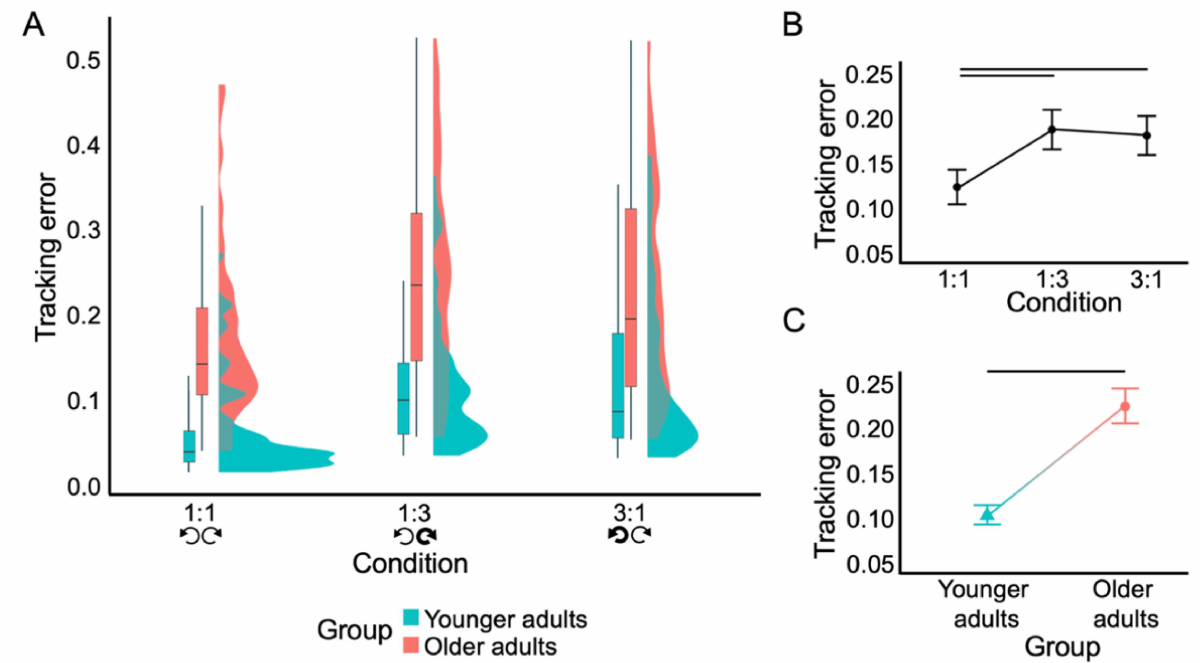
Figure 2. Performance on bimanual tracking task. The tracking error represents compliancy with the imposed movement condition, with a lower value representing better performance. ( A ). Box- and violin plots showing tracking error distribution per age group and condition. Whisker length is 1.5 × interquartile value. ( B ). Effect of condition on tracking error. ( C ). Effect of group on tracking error. Errors bars in ( B , C ) denote 95% confidence intervals, horizontal black lines denote significant post-hoc